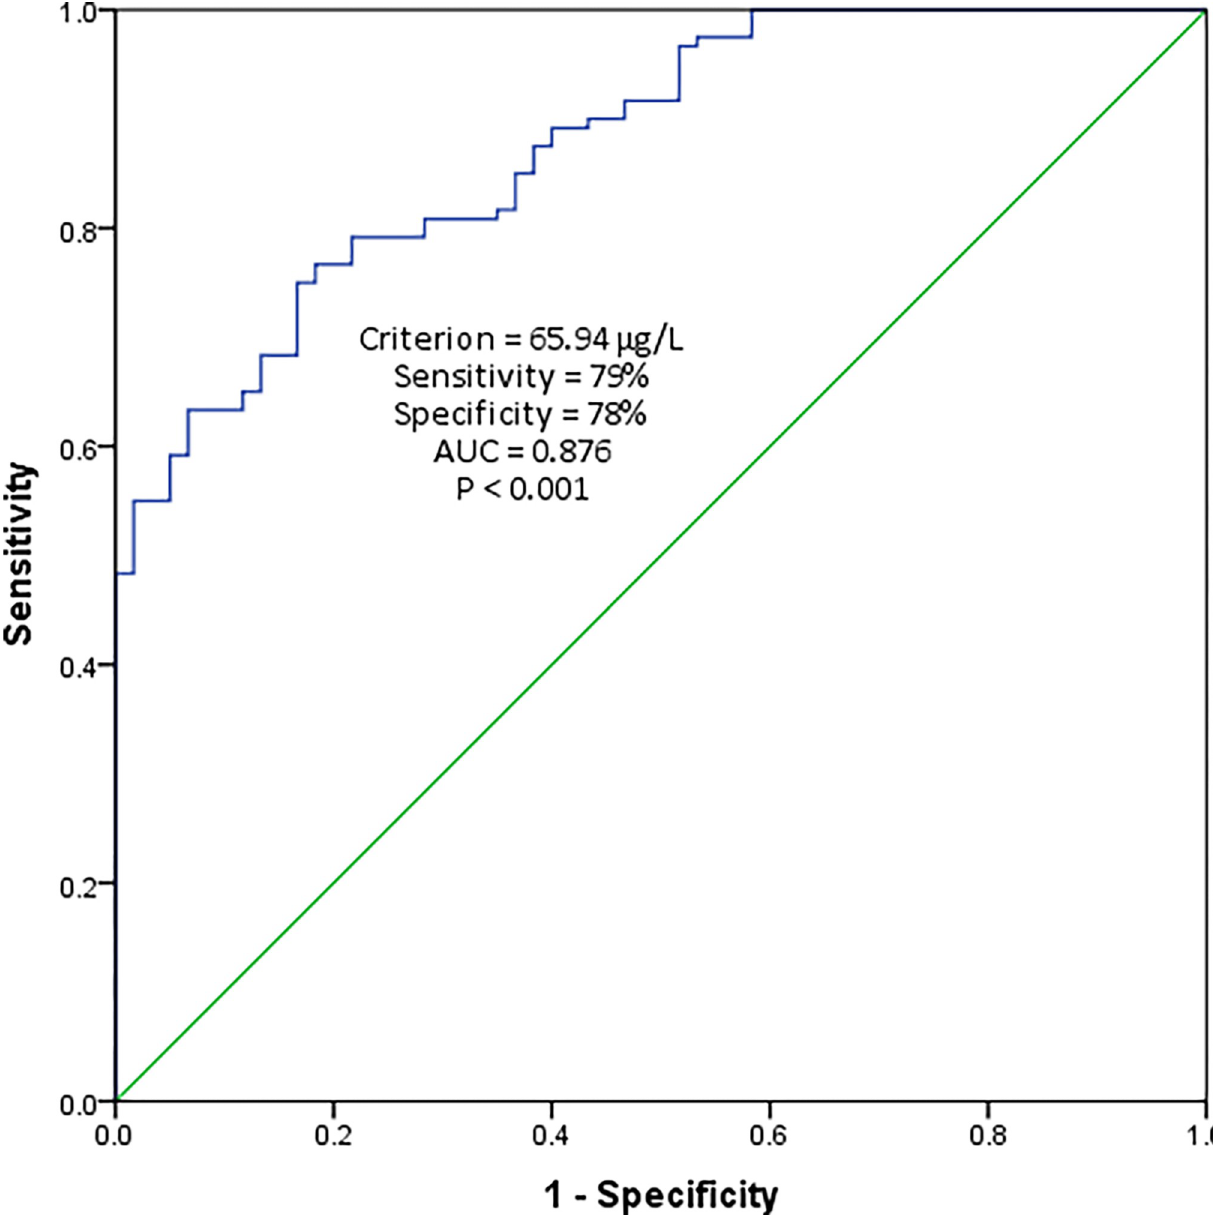
Fig 2. Receiver operating characteristic (ROC) curve analysis for distinguishing of polycystic ovary syndrome (PCOS) using serum CTRP15. AUC: area under the curve.